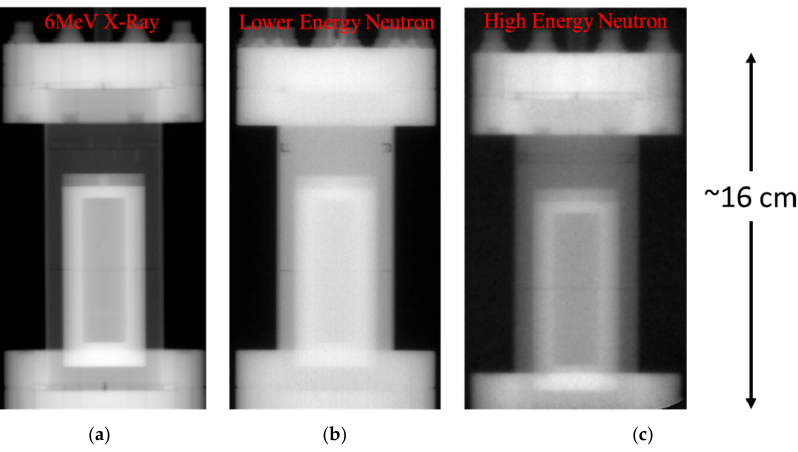
Figure 20. Radiographs taken with ( a ) 6 MeV Bremsstrahlung source (Microtron) ( b ) TOF-gated 4FP-60R image for few MeV neutrons ( c ) higher energy neutrons. Notice the better penetration of the X-rays and higher energy neutrons through the plastic at the top. The X-ray set up is highly optimized while the neutron set up was a “first time” operation. The object is about 16 cm tall. The object is not at the same angular orientation in the different images.